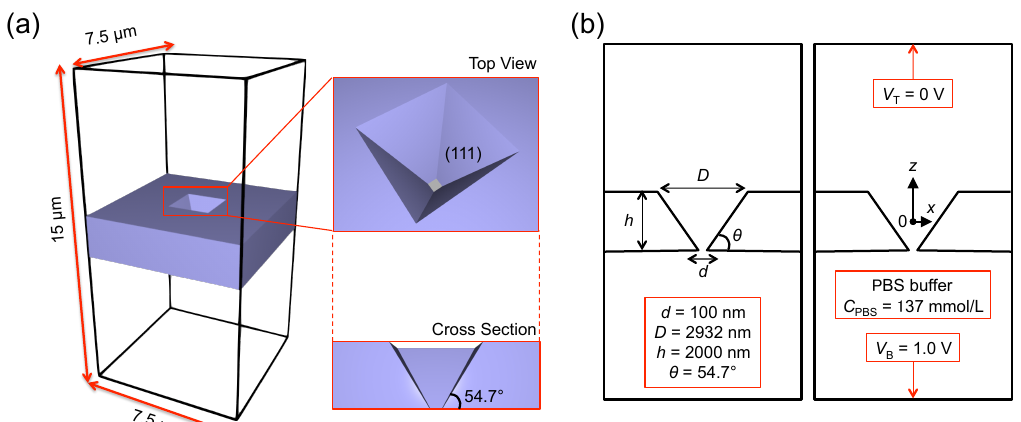
Figure 2. Simulation model for the inverted pyramid (IP)-shaped nanopore devices. ( a ) The three-dimensional IP-shaped nanopore model with D = 2932 nm and d = 100 nm. The xy -size and height for the cis and trans chambers are 7.5 × 7.5 µ m and 6.5 µ m, respectively. As the IP-shape nanopore is envisioned to be fabricated by an anisotropic wet etching on a (100) silicon wafer, the slope angle is 54.7 ◦ . ( b ) Definitions of the model size, the coordinate origin, the bias voltage, and the concentration of phosphate-bu ff ered saline (PBS) buffer.